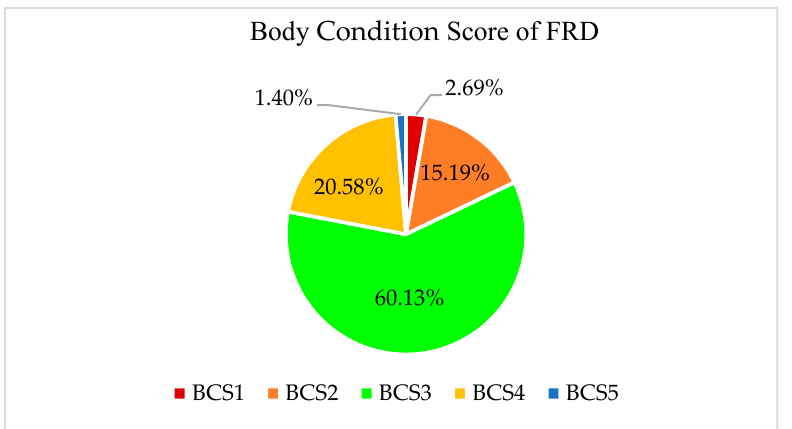
Figure 6. Body-condition score (BCS) of FRDs (assessed based on visual observation with regards to features that the ACIM organization has defined for each category of body-condition scoring of dogs).